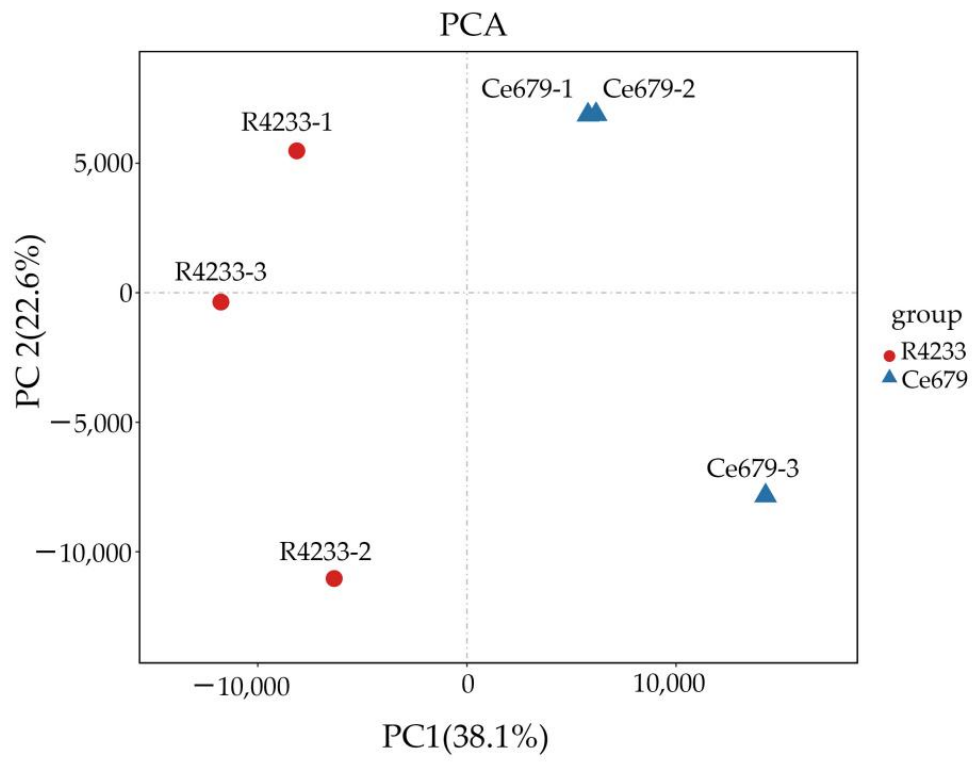
Figure 6. PCA of detected peaks in a young panicle of Ce679 compared with R4233 through LC- MS/MS. PCA scores were derived from the metabolites detected in the three replicated samples. We performed a correlation analysis on DAMs and DEGs. Nine quadrant diagrams were drawn, elucidating the metabolites’ variations and their corresponding genes with a Pearson correlation coefficient over 0.99, and the correlation coefficient clustered heat map (Figure 7). It showed that quadrants 9 and 7 had more DAMs and DEGs than other